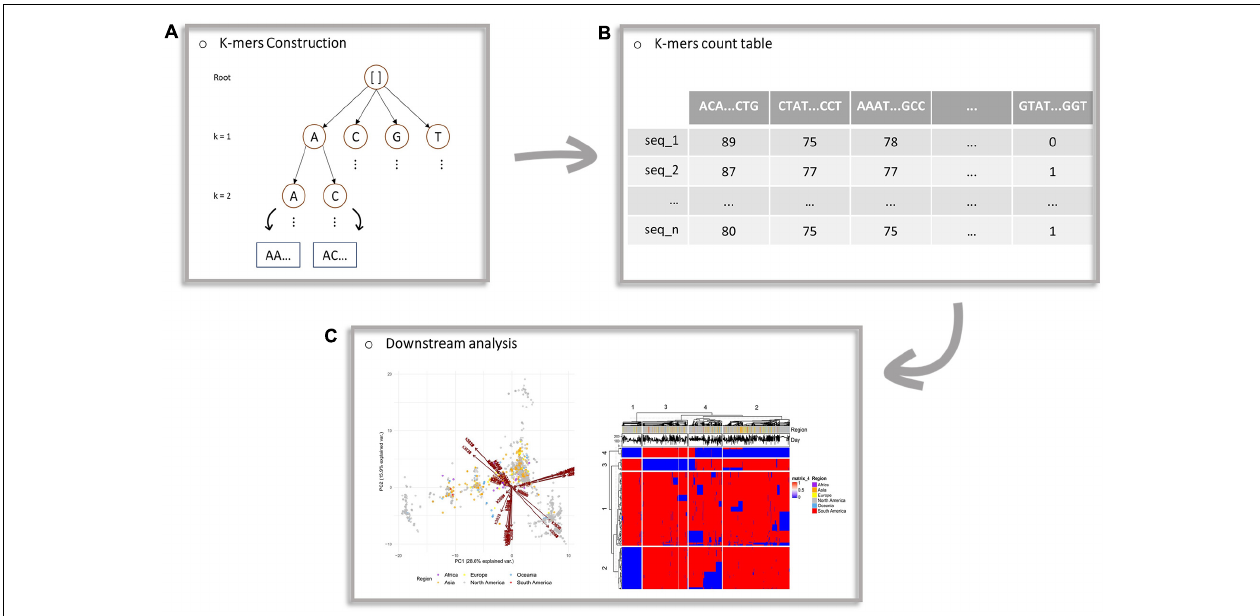
FIGURE 1 | Schematic workflow of the proposed framework. (A) Construction of an evaluation tree. (B) The generated count table, with k -mers of multiple lengths as features (columns) and sequences as observations (rows). Each cell of the table corresponds to the number of occurrences of a k -mer to a particular sequence. (C) Principal components analysis projection on a two-dimensional space and the heatmap generated from downstream analysis of the algorithm’s